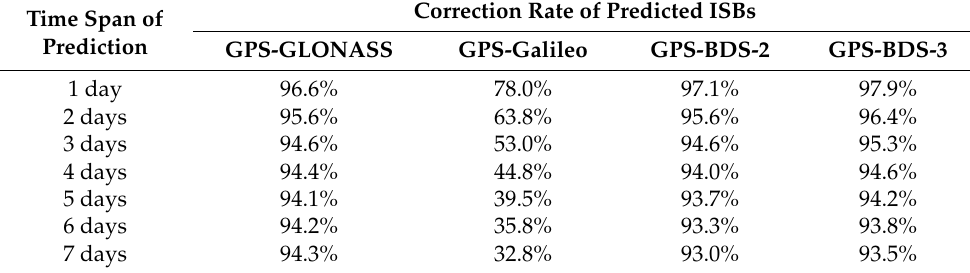
Table 3. Correction rate of predicted daily ISBs with a time span of prediction from a day to seven